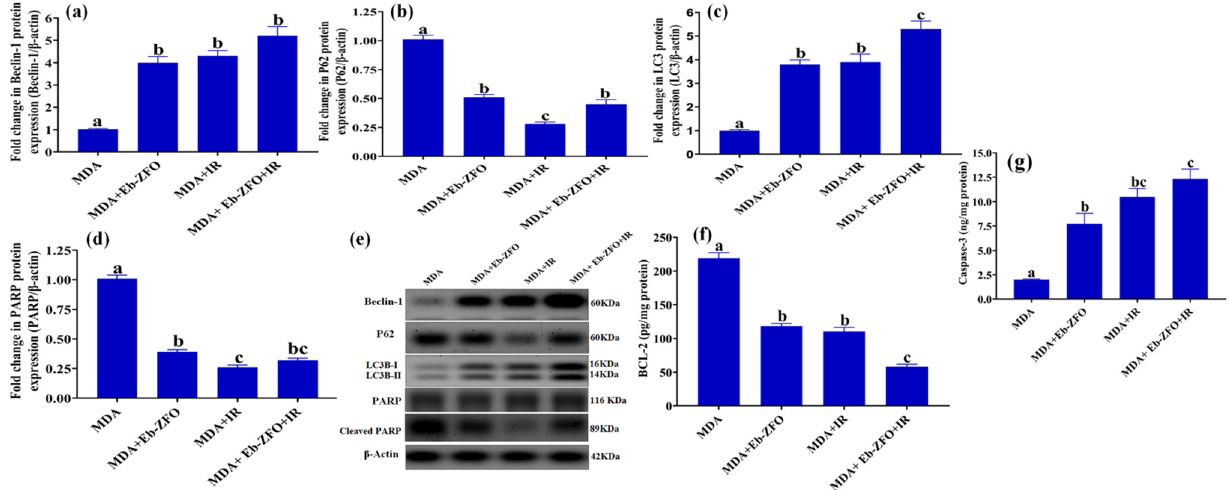
Figure 17. Autophagy and apoptosis in MDA-MB-231 cells. Represented as follows: fold change in protein expression of ( a ) beclin-1, ( b ) P62, ( c ) LC3B-II, ( d ) cleaved PARP-1, ( e ) representative western blot analysis, SDS-PAGE of beclin-1, P62, LC3B-II/LC3B-I, cleaved PARP-1 and β -actin, ( f ) BCL-2, and ( g ) cleaved caspase-3 protein levels. Results are expressed as the mean and standard error of the mean (SEM) (n = 3). Columns with dissimilar letters (a, b, c…) overhead within the same histogram are significantly different, and columns with the same letters are not significantly different at p < 0.05. MDA group: untreated MDA-MB-231 cells served as control; MDA + Eb-ZFO group: MDA-MB-231 cells treated with Ebselen (Eb) and ZnFe 2 O 4 nanoparticles (ZFO); MDA + IR group: MDA-MB-231 cells exposed to γ -radiation; and MDA + Eb-ZFO + IR group: MDA-MB-231 cells treated with Eb-ZFO and exposed to IR.